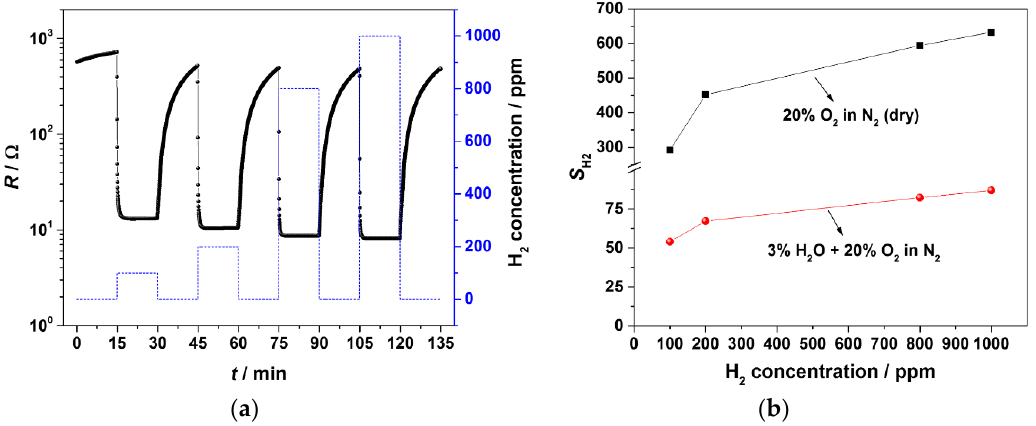
Figure 7. ( a ) Resistance of AD-coated SnO 2 sensor under different H 2 concentrations (100 to 1000 ppm) in base gas (3% H 2 O and 20% O 2 in N 2 ) at 400 °C (dotted line shows the concentration of H 2 ), ( b ) comparison of the sensor response towards H 2 in dry base gas and with 3% H 2 O added base gas.